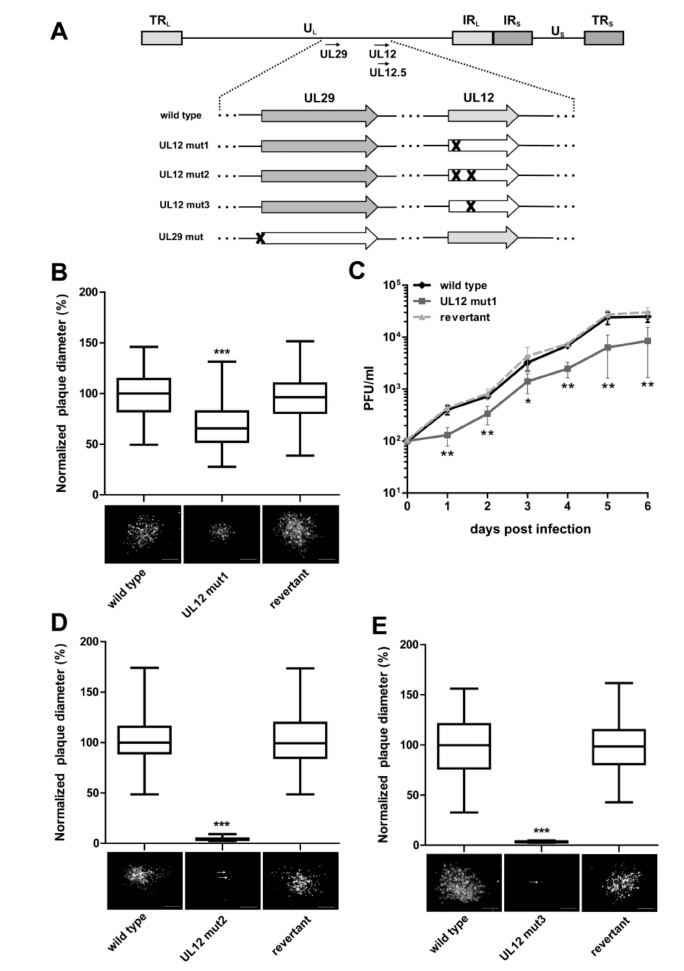
Figure 1. Generation and characterization of recombinant mutant viruses. ( A ) Schematic representation of the Marek’s disease virus (MDV) genome, with a focus on the unique long (UL) region containing the UL12 and UL29 genes. Mutations in UL12 (stop codon insertion at aa 6/7 and/or aa 136) and UL29 (stop codon at aa 1) are indicated. ( B ) Chicken embryo cells (CEC) were infected with 100 PFU of wild type MDV, UL12 mut1, or the revertant viruses. The average plaque diameters from three independent experiments, normalized to wild type, are shown in the box plots. Representative images of plaques are shown below (Scale bar, 100 µ m). ( C ) CEC were infected with 100 PFU of wild type, UL12 mut1, and revertant viruses, and the titer determined at indicated times post-infection. Shown are the mean titers of these viruses from three independent experiments ± SEM (**, p ≤ 0.05; *, p = 0.01; Mann–Whitney U test). Wild type, ( D ) UL12 mut2, ( E ) UL12 mut3, and respective revertant MDV BACs were transfected into CEC and images of plaques acquired six days post-transfection. The average plaque diameters from three independent experiments are shown in box plots (normalized to wild type). Representative images of plaques are shown below (Scale bar, 100 µ m). White arrows show single infected cells. Statistical differences in plaque diameters were determined using one-way ANOVA analyses (***, p <